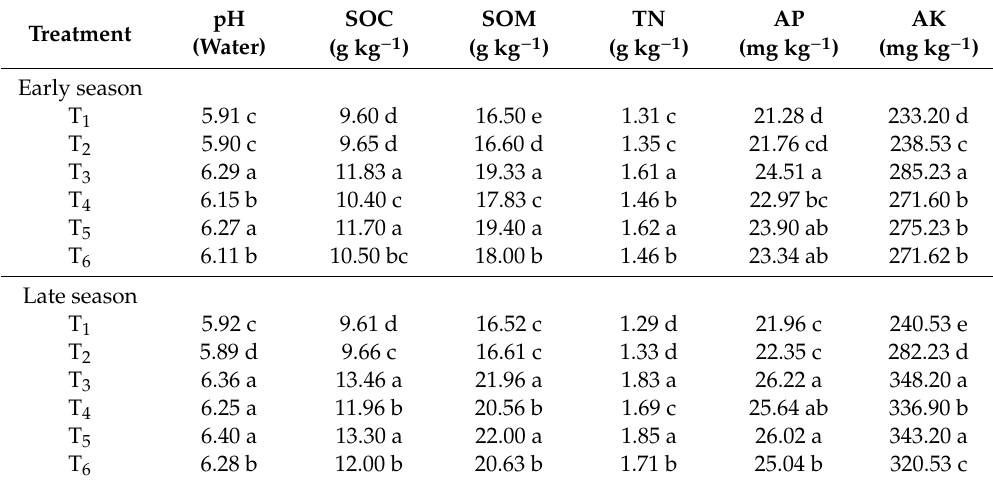
Table 5. Changes in soil chemical properties under combined organic and inorganic fertilizers. pH SOC Treatment